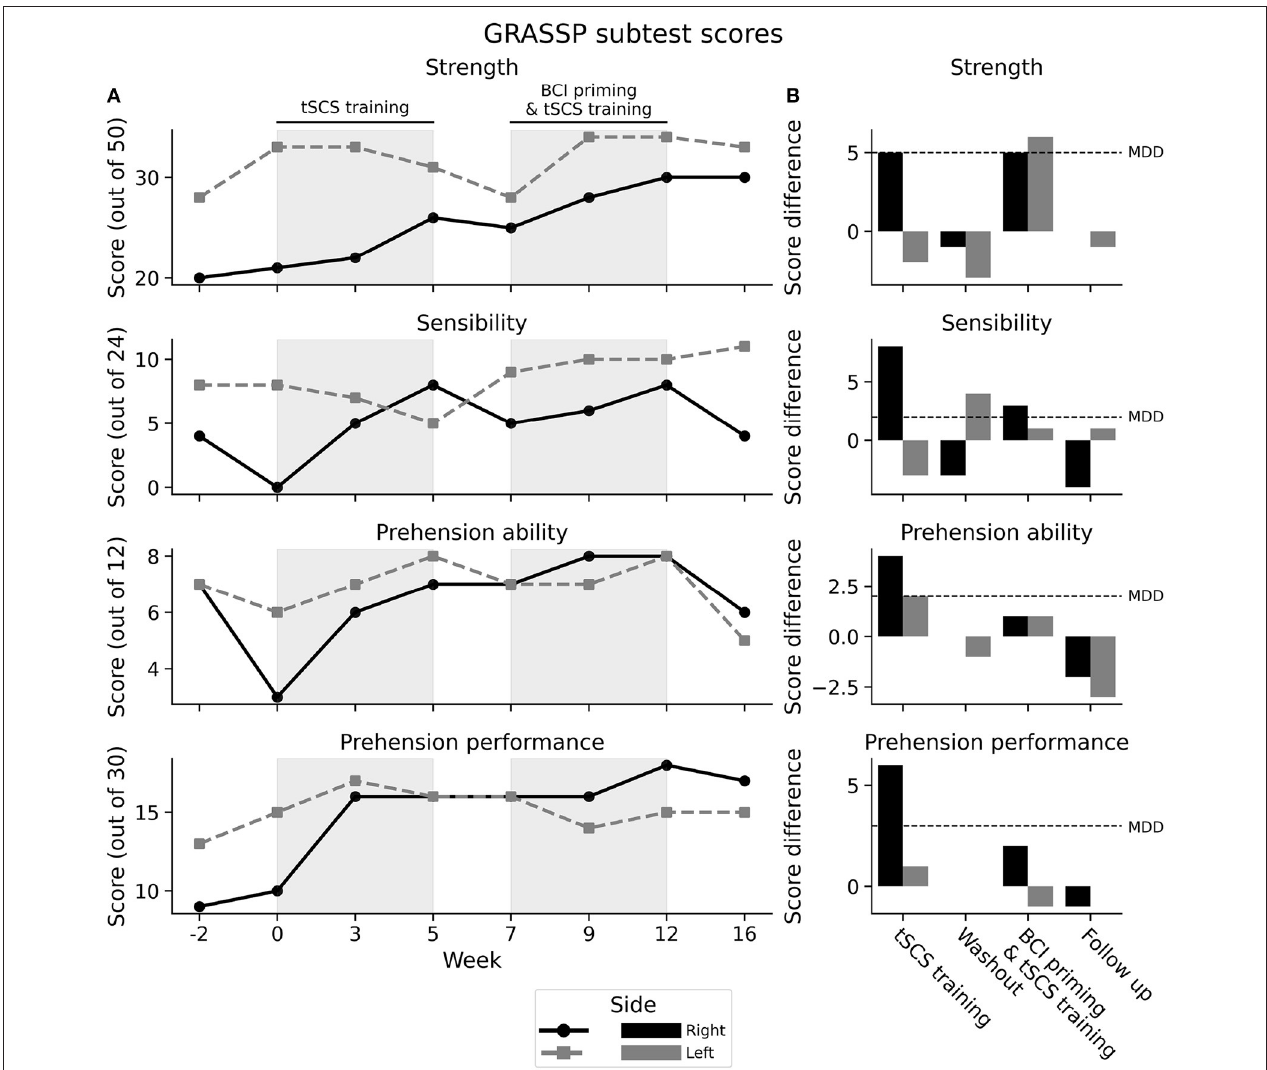
FIGURE 3 | GRASSP subtest scores. (A) Subtest scores from the Graded Redefined Assessment for Strength, Sensibility, and Prehension (GRASSP) Strength across the study. Shaded areas indicate the two therapeutic phases: “tSCS training” and “BCI priming & tSCS training”. (B) Unilateral differences across each phase. Left and right side is indicated with gray and black, respectively. The minimally detectable difference (MDD) is the minimum score change required such that the difference cannot be attributed to measurement error (with 95% certainty). MDD is illustrated with a horizontal dashed